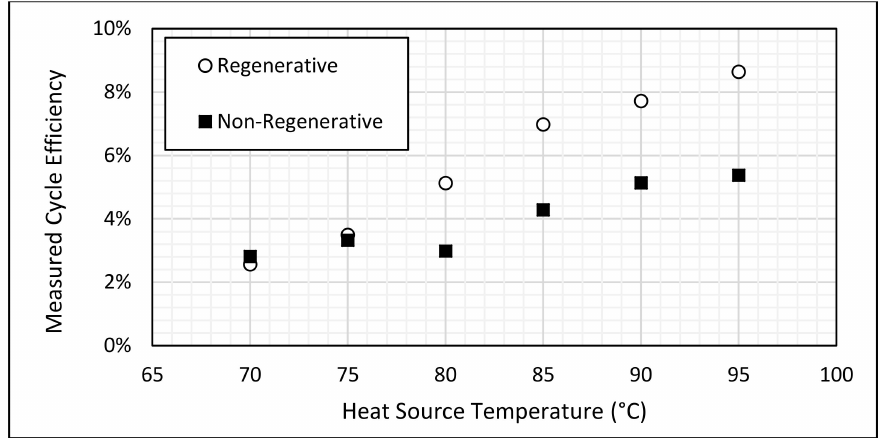
Figure 4. Variation in measured cycle e ffi ciency with varying heat source temperature for regenerative and non-regenerative cycles, for a pump speed of 40 Hz.